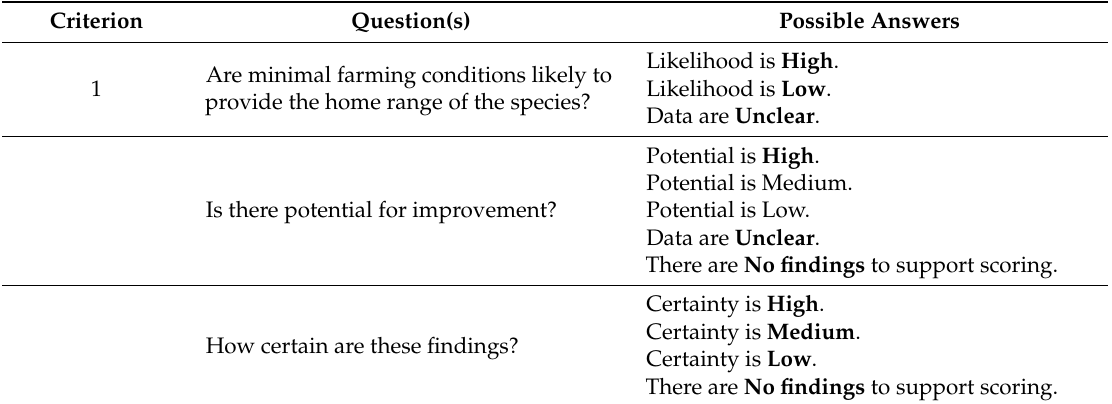
Table 2. Questions regarding the 10 selected criteria for the Short Profiles in the FishEthoBase